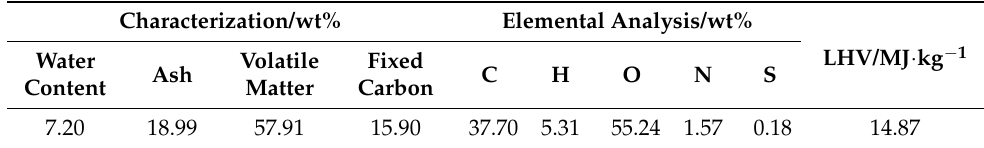
Table 2. Characterization and elemental analysis of tobacco stalk.